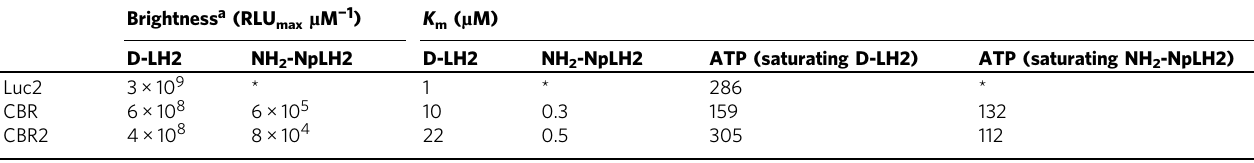
Table 2 Kinetic parameters for beetle luciferases and